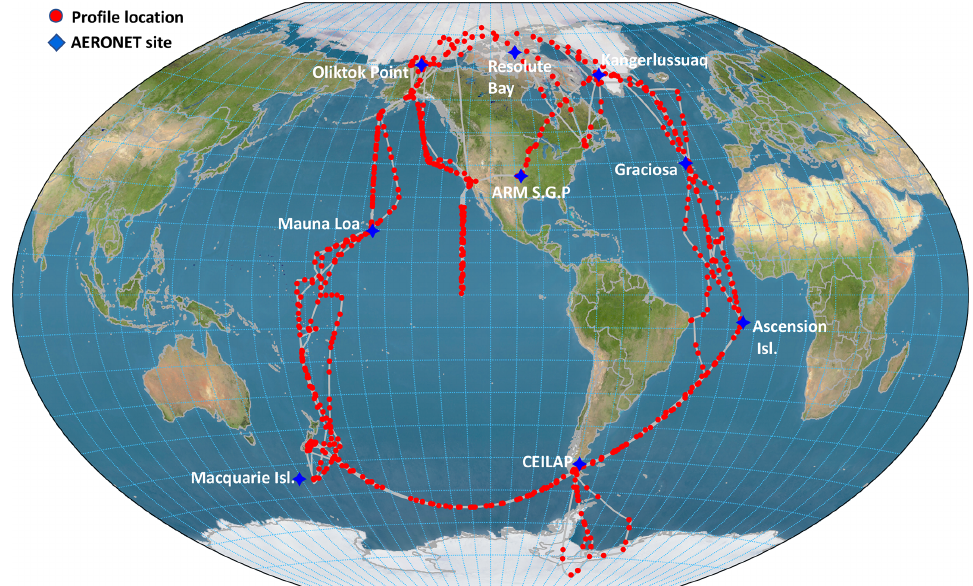
Figure 1. Map showing the flight track of the DC-8 aircraft (gray lines) and midpoint location of each vertical profile (ascent or descent; red circles). Locations and names of AERONET sites against which calculated AOD is compared are shown by blue diamonds and labels. Custom map produced using 1km digital elevation model data from NOAA (https://www.ngdc.noaa.gov/mgg/topo/globe.html, last access: 3 February